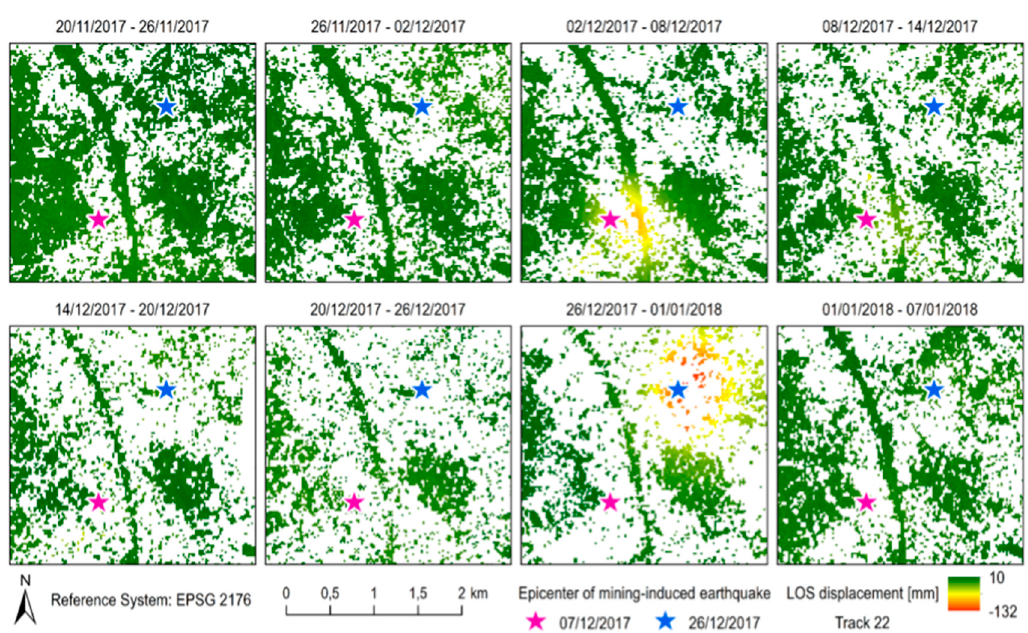
Figure 6. Line of Sight (LOS) terrain surface displacements maps retrieved from Sentinel-1 descending orbit (track 22) in the period between 20th November 2017–7th January 2018.